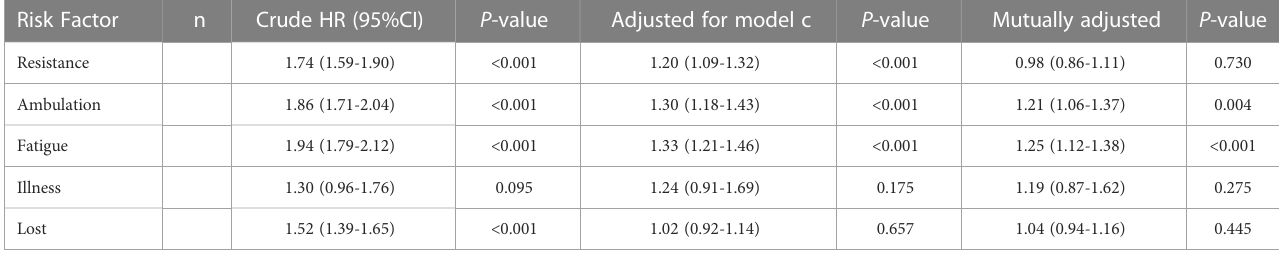
TABLE 3 Associations of Frailty and Components With Overall Survival.